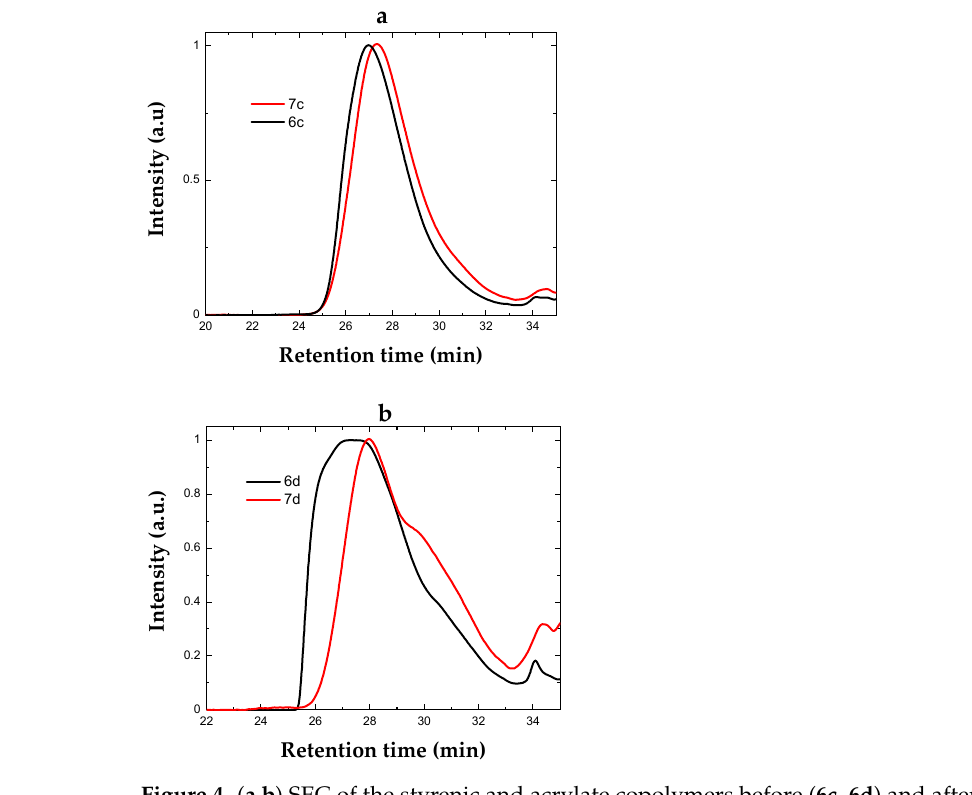
Figure 4. ( a , b ) SEC of the styrenic and acrylate copolymers before ( 6c , 6d ) and after complexation ( 7c , 7d ), respectively.